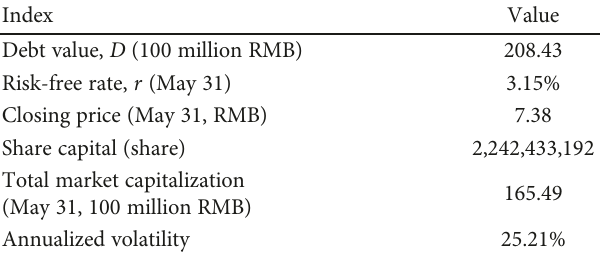
Table 8: Relevant fi nancial data of HH joint stock company of Jiangsu